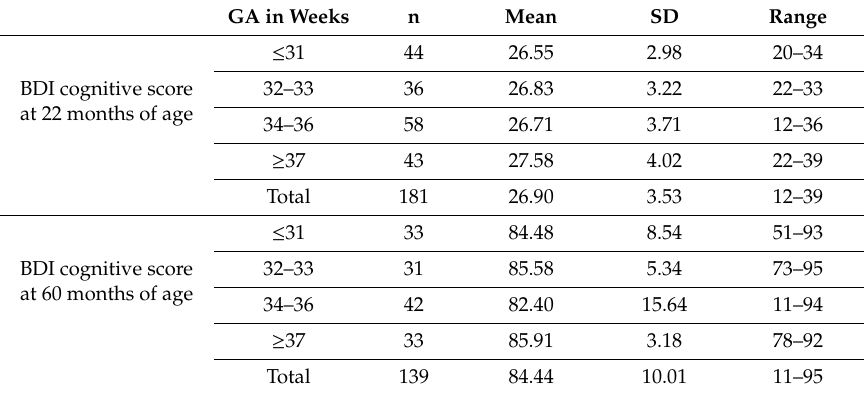
Table 2. Descriptive results of cognitive development by gestational age